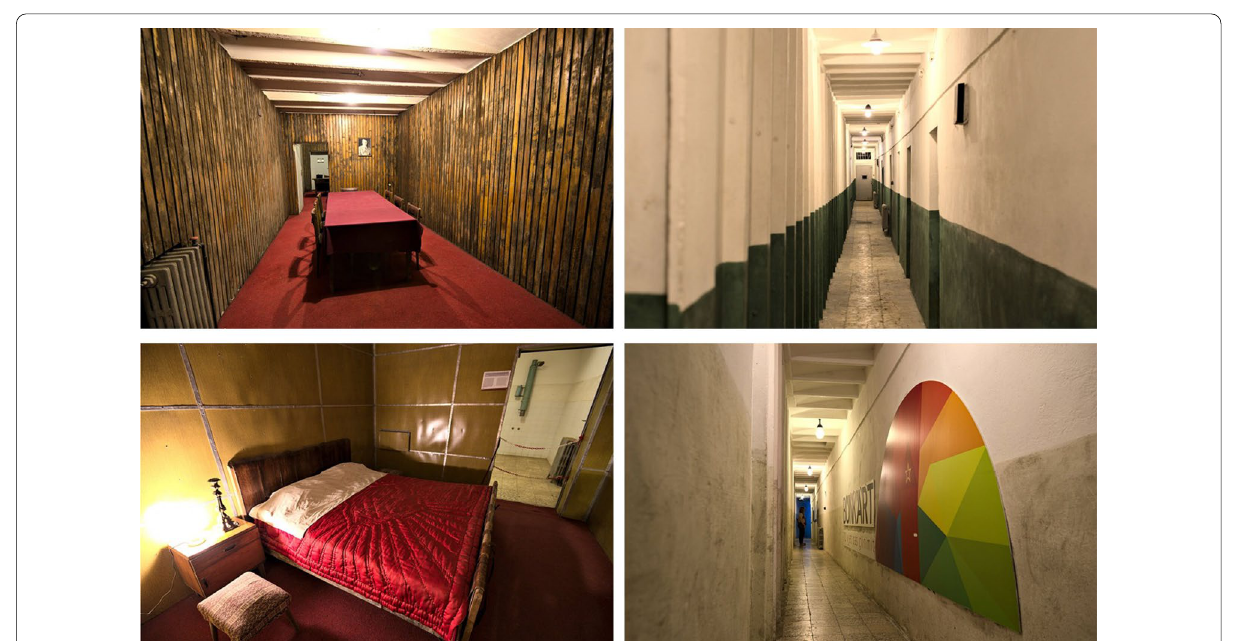
Fig. 8 Photos from the interior of the museum Bunkart 1, curated by Carlo